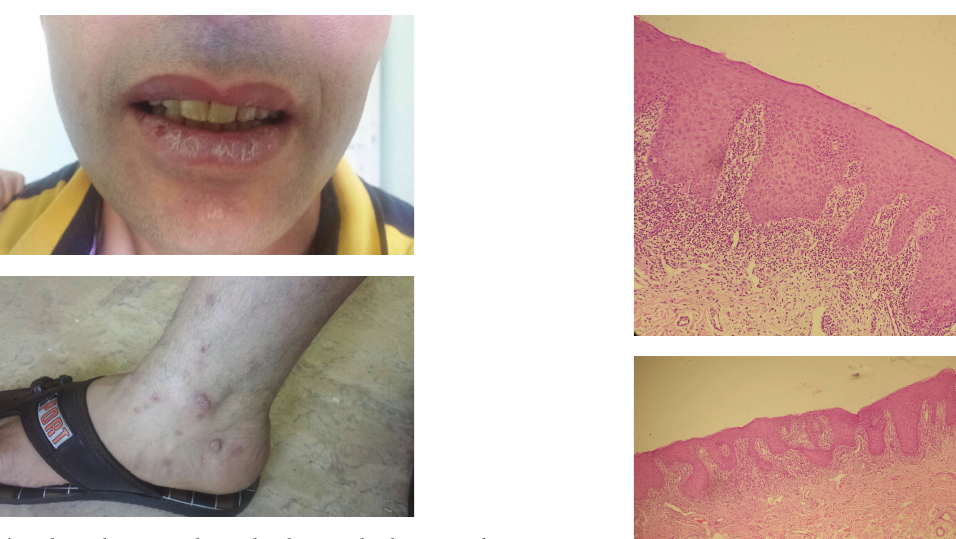
Figure 1: The white plaques on lip and itchy papular lesion in the foot.